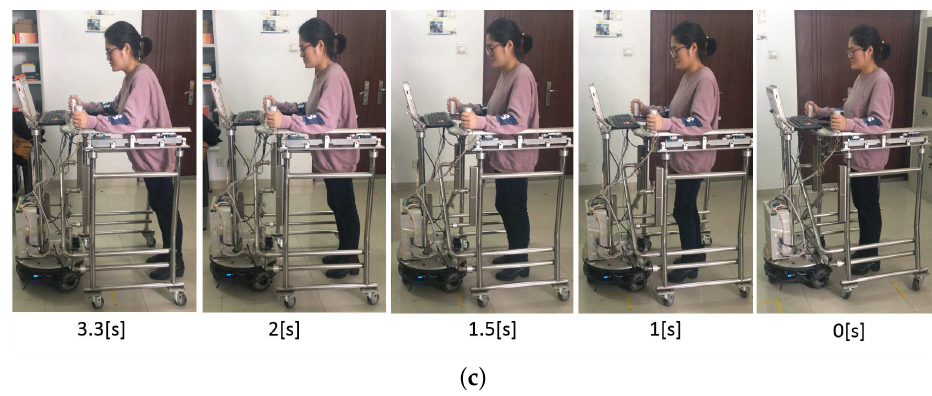
Figure 13. The results of the falling forward experiment. ( a ) The HMI velocities estimated by HMI Estimation Algorithms I and II and the actual robot moving velocities by the KF-based coordinated motion fusion algorithm when the subject falls forward. ( b ) The result of fall mode detection when the subject falls forward. ( c ) The process of falling forward.